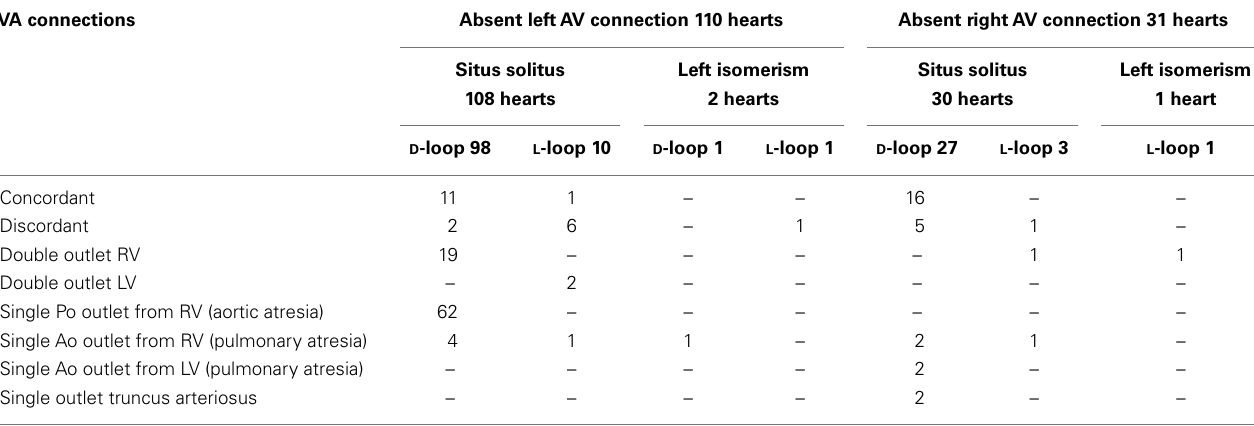
Table 6 |AbsentAV connections: ventriculo-arterial connections .